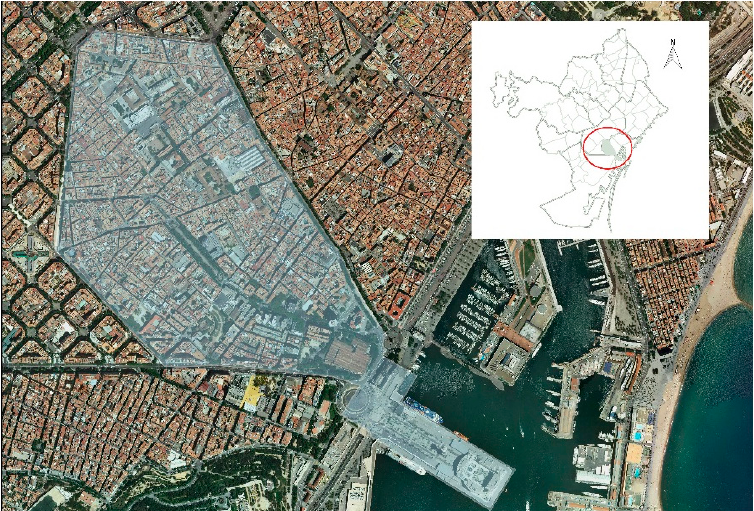
Figure 5. Location of the Raval neighborhood. Source: own elaboration.